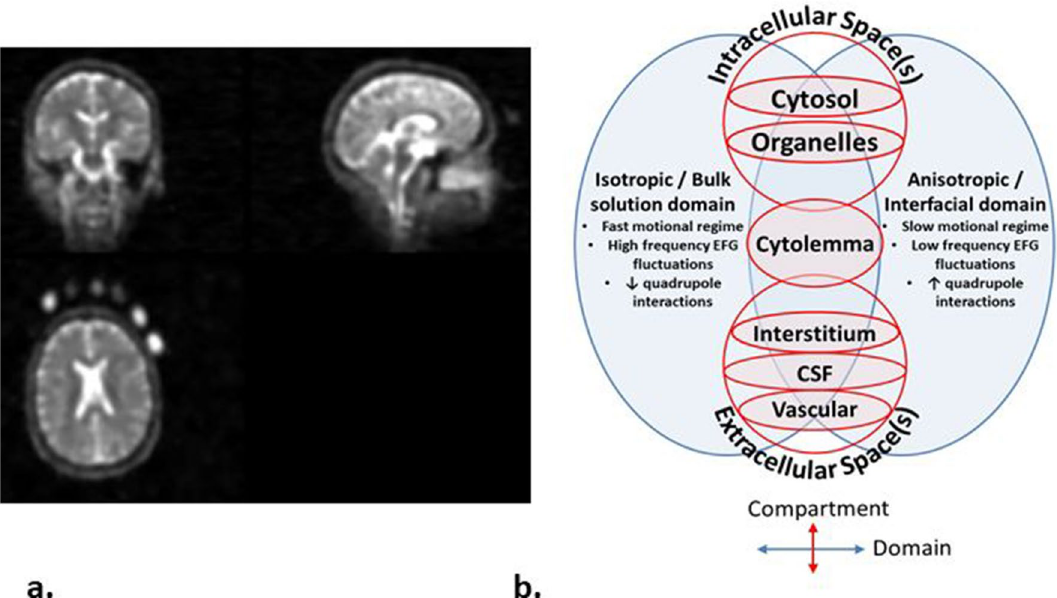
Figure 1. 23 Na magnetic resonance imaging. ( a ) An exemplar 23 Na-MRI brain image, with external calibration phantoms of differing concentrations visible on the bottom left axial image. Calibration can also be done relative to internal references such as vitreous humor or cerebrospinal fluid in the ventricles. ( b ) Schematic Venn diagram (following the nomenclature in Springer 28 ) showing physical domains (Blue) where nuclei share similar nuclear magnetic resonance properties, and biological compartments (Red) found in brain tissue. These are arrayed along two axes to indicate their orthogonality: neither physical domain is unique to any given biological compartment. 23 Na-MRI TSC estimates are a weighted average influenced by concentrations, volumes and microstructure in a range of environments including the intracellular (neuronal and glial cytosol, and organelles), extracellular (interstitial and vascular spaces.) and membranous